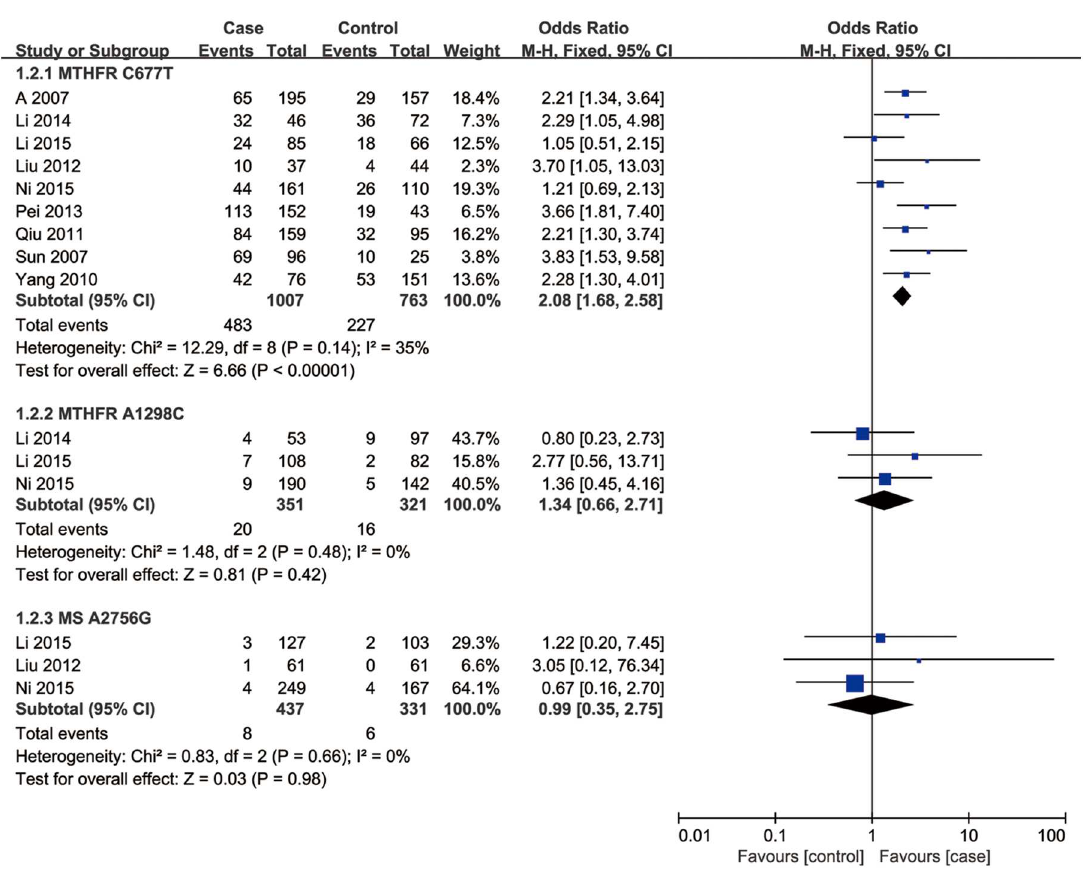
Fig 4. Forest plot of the studies assessing the association between MTHFR C677T, MTHFR A1298Cand MS A2756G polymorphisms and male infertility. (additivemodel: (a) TT vs. CC, (b) CC vs. AA, (c) GG vs.